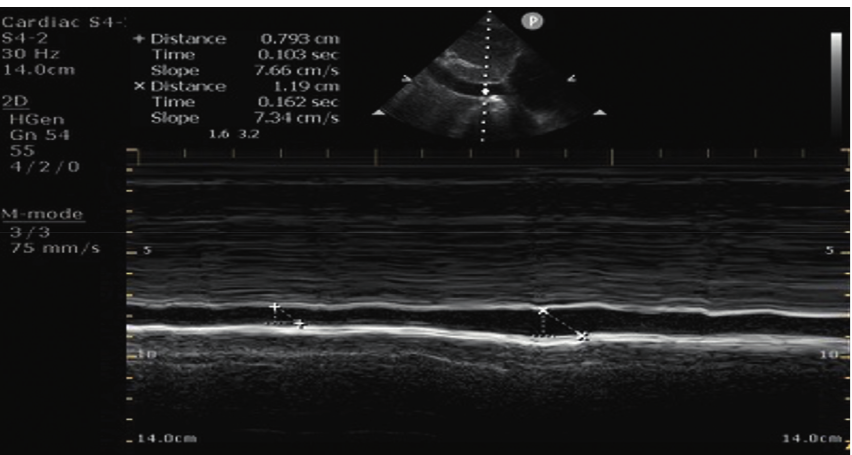
Figure 2: The maximum inferior vena cava diameter (dIVC max ) was measured as the maximum anterior-posterior dimension at end- expiration using the leading-edge technique (inner edge to inner edge of the vessel wall). The minimum inferior vena cava diameter (dIVC min ) was measured at end-inspiration. The collapsibility index was calculated using the built-in software available on the ultrasound systems. IVC: inferior vena cava; dIVC max : maximum IVC diameter; dIVC min : minimum IVC